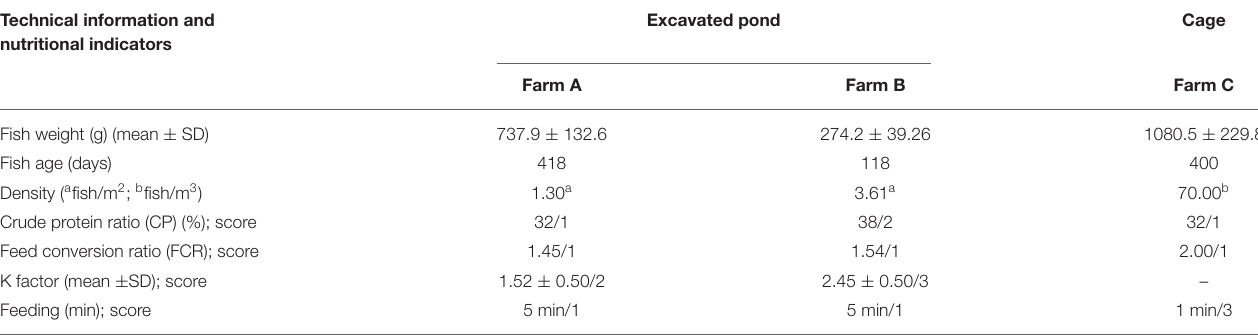
TABLE 8 | Nutritional indicators and related information for three different tilapia grow-out farms data collected from January to March 2020 in South and Southeast regions of Brazil. Technical information and nutritional